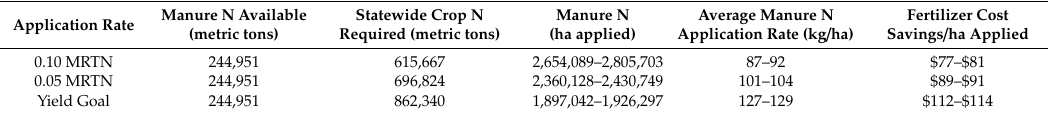
Table 8. Estimated Commercial Fertilizer Replacement Cost